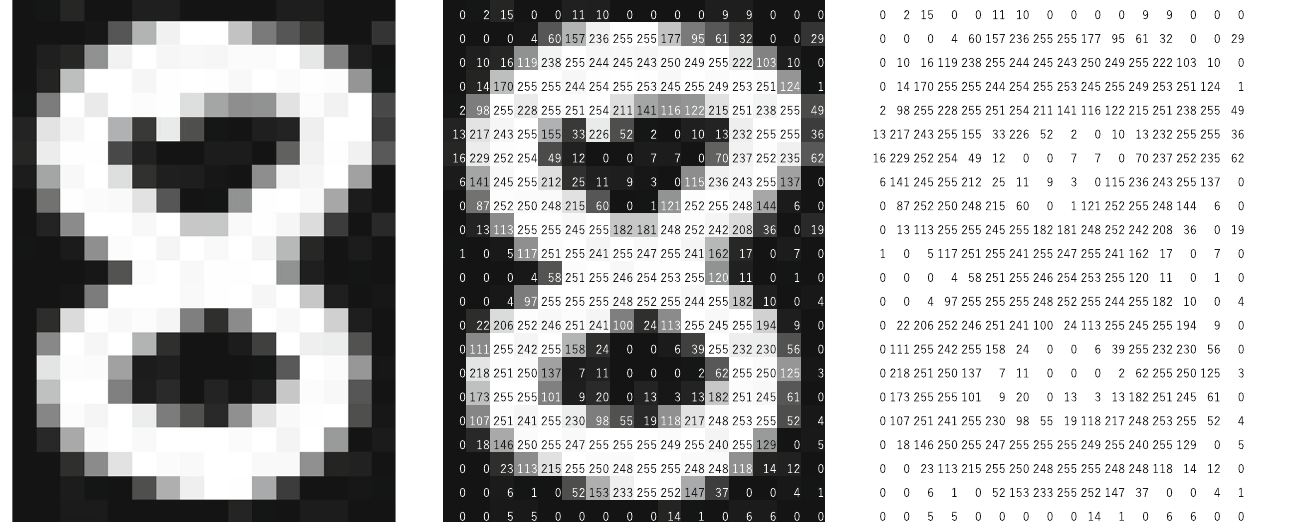
Fig. 1 An overview of a convolutional neural network (CNN) architecture and the training process. A CNN is composed of a stacking of several building blocks: convolution layers, pooling layers (e.g., max pooling), and fully connected (FC) layers. A model ’ s performance under particular kernels and weights is calculated with a loss function through